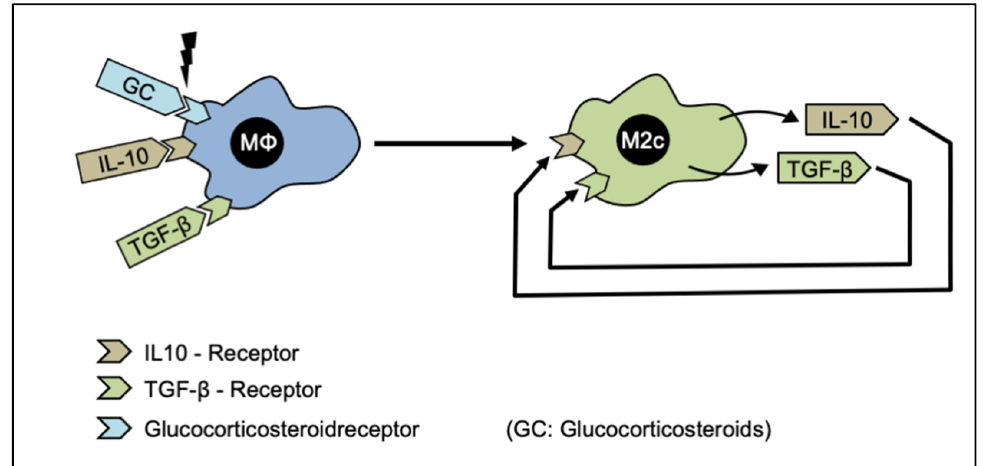
Figure 8. The polarization to M2c-Macrophages. In the presence of glucocorticoids (GC), IL-10 or TGF- β receptor ligands, the macrophages adopt the M2c phenotype, which is capable of synthesizing IL-10 and TGF- β and thus reaching a state of self-activation.